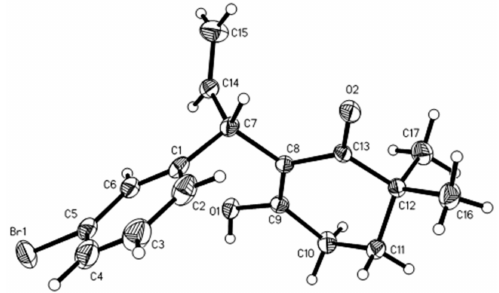
Figure 2. X-ray molecular structure of 3j